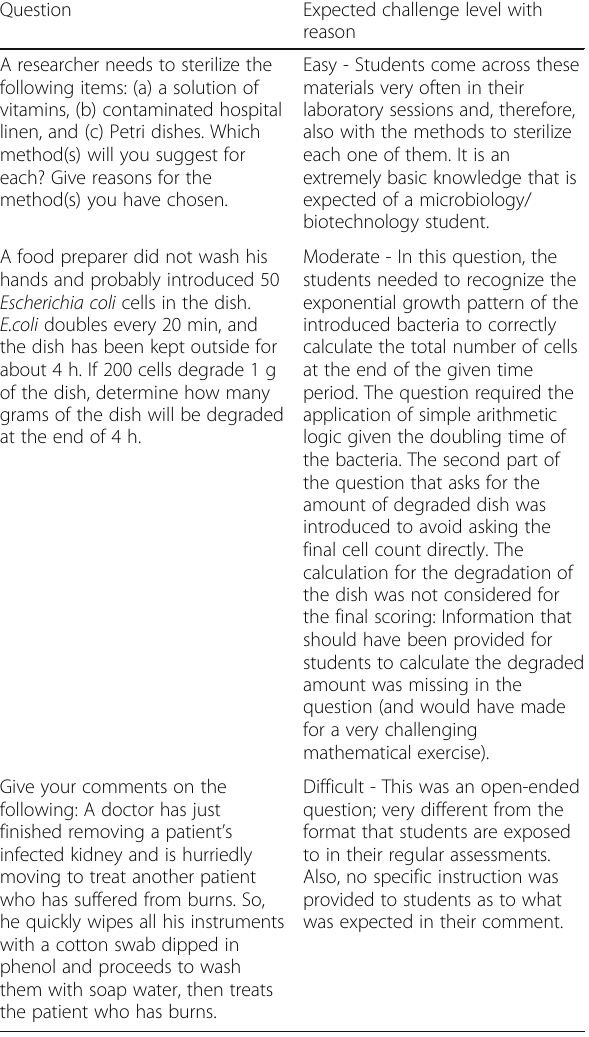
Table 2 Questions and the expected challenge level